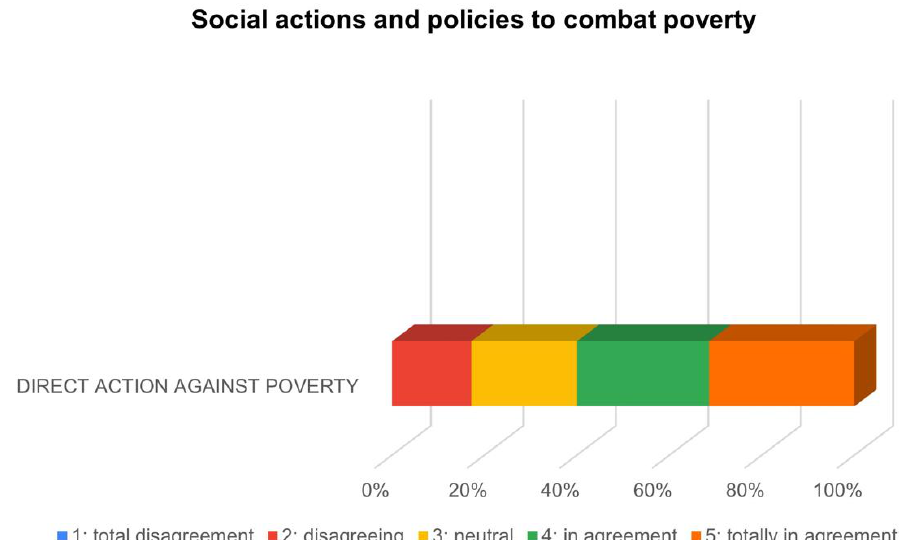
Figure 9. Social actions and policies to combat poverty.